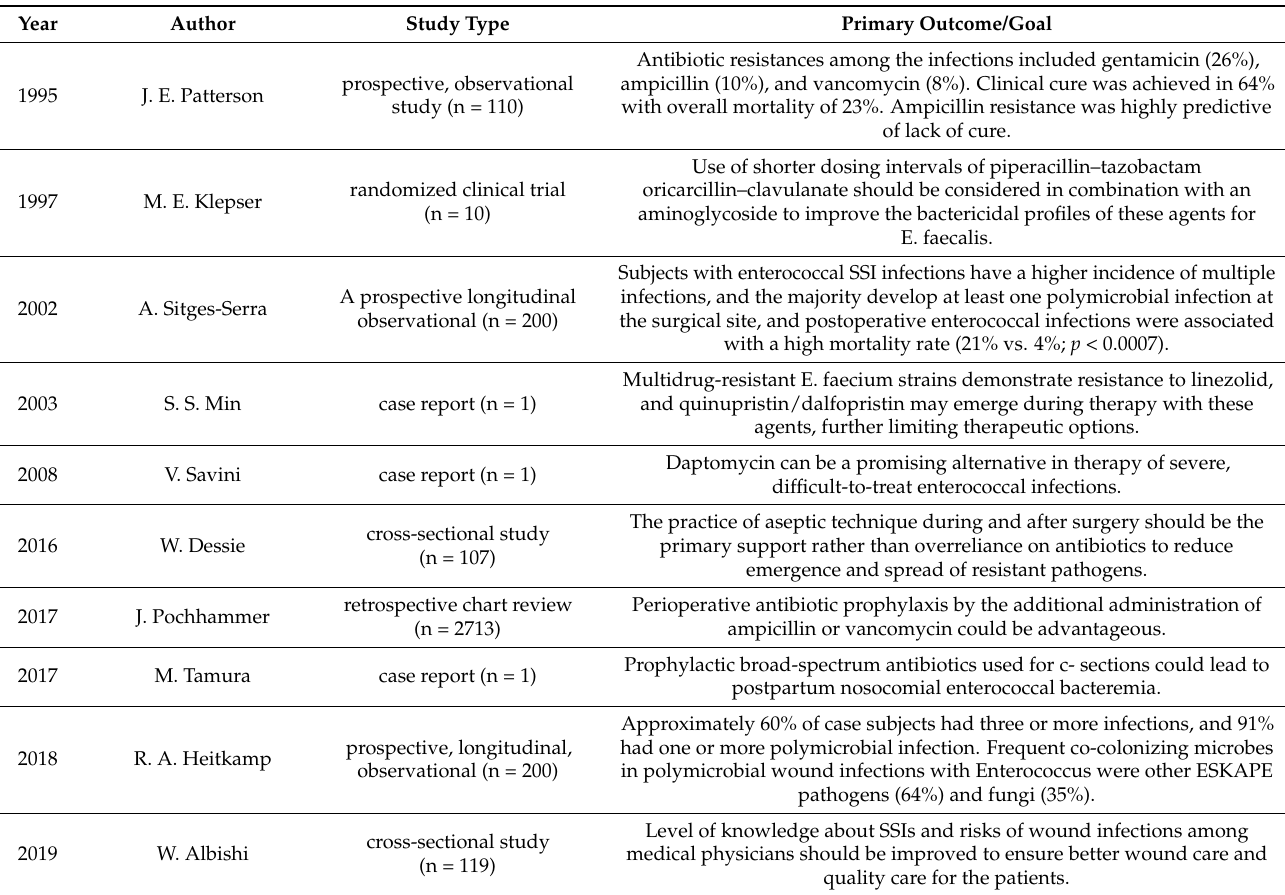
Table 1. Enterococcus in surgical